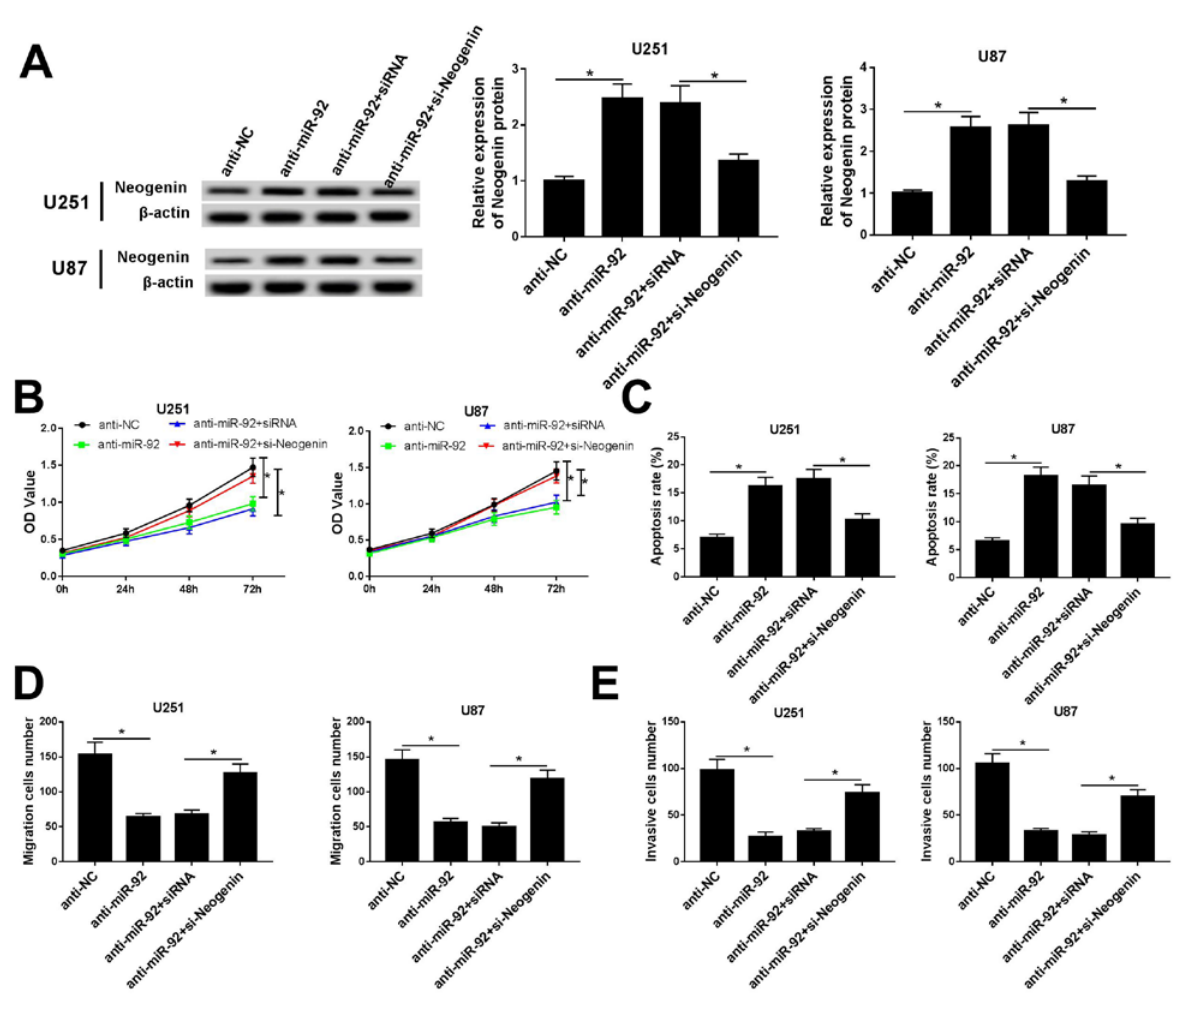
Figure 5: Neogenin upregulation mediated the protective effect of miR-92 on glioma cell proliferation, migration and invasion. U251 and U87 cells were transfected with anti-miR-92 or anti-NC, and co-transfected with anti-miR-92 and siRNA against neogenin (si-Neogenin) or its scrambled sequence (siRNA). (A) Expression level of neogenin protein was measured by western blot assay after transfection. (B) The cell proliferation ability was evaluated by MTT assay after transfection for different times (24 h, 48 h and 72 h). (C) Glioma cell apoptosis rate was detected after transfection for 24 h by flow cytometry. (D and E) The migration and invasion abilities of U251 and U87 cells were perfor- med after transfection for 24 h by transwell assay. *P <